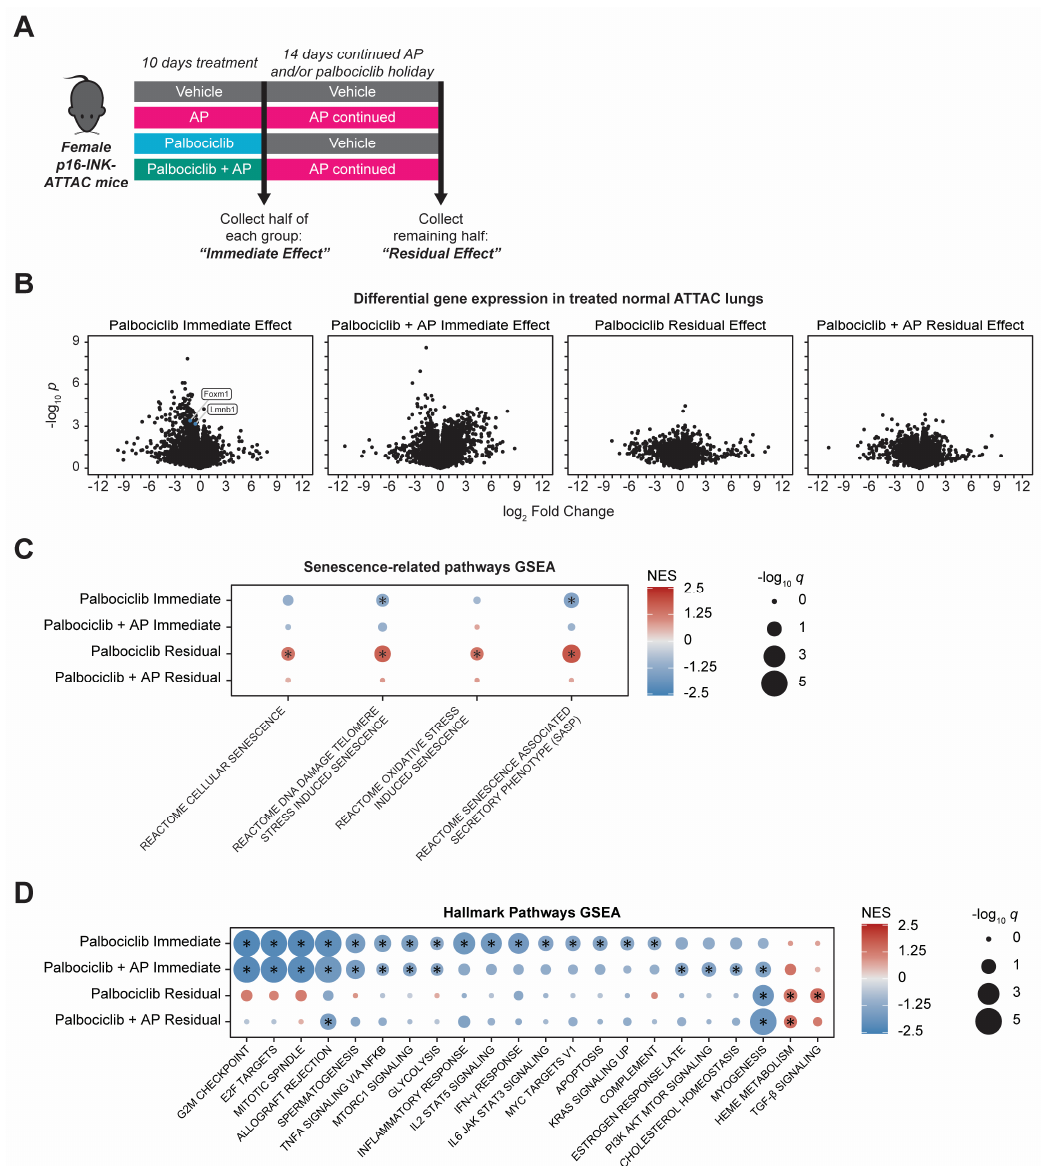
Figure 2. Palbociclib-induced gene expression changes in normal lung are partially reversed by coadministration of AP20187. ( A ) A cohort of 24 female ATTAC mice were randomized into four groups ( n = 6 per group) for a 10-day treatment period: vehicle, AP20187 (AP) 2 mg/kg every three days (four total doses) by intraperitoneal injection, palbociclib 150 mg/kg daily by oral gavage (10 total doses), or combined palbociclib + AP. Following 10 days of treatment, three mice in each of the groups were euthanized for analysis (“Immediate Effect” cohort). The remaining mice were treated with a 14-day holiday from palbociclib or with 14 days of continued AP 2 mg/kg every three days (five additional doses) prior to collection (“Residual Effect” cohort). ( B ) Volcano plots of differentially expressed genes (DEGs) regulated by 10 days of palbociclib with or without drug holiday or by 10 days of palbociclib + AP with or without 14 days of continued AP. Three independent biological replicates (one RNA sample from each mouse) sequenced per group. Full list of DEGs available in Supplemental File S1. ( C , D ) Gene set enrichment analysis of lung RNA from experiment described in ( A ), for senescence-related pathways ( C ), and for MSigDB Hallmark gene sets ( D ). Color indicates normalized enrichment score (NES), and size indicates statistical significance. All pathways graphed reached statistical significance in at least one treatment condition or were excluded: * absolute value of normalized enrichment score (NES) > 1.25 and q <